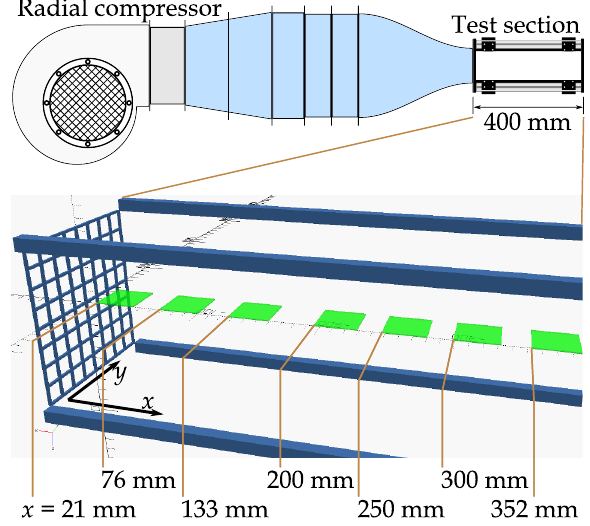
Fig. 1. Sketch of the wind tunnel (top) and the position of the studied areas in respect to the grid, which is located at the inlet into the transparent test section.